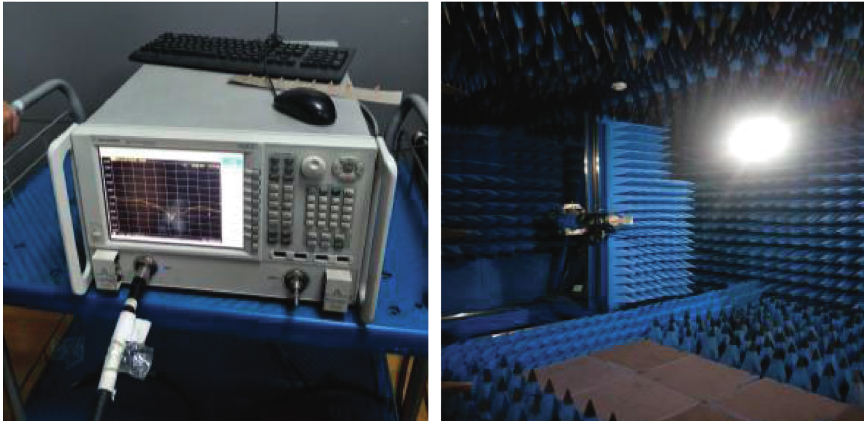
Figure 17: The measured